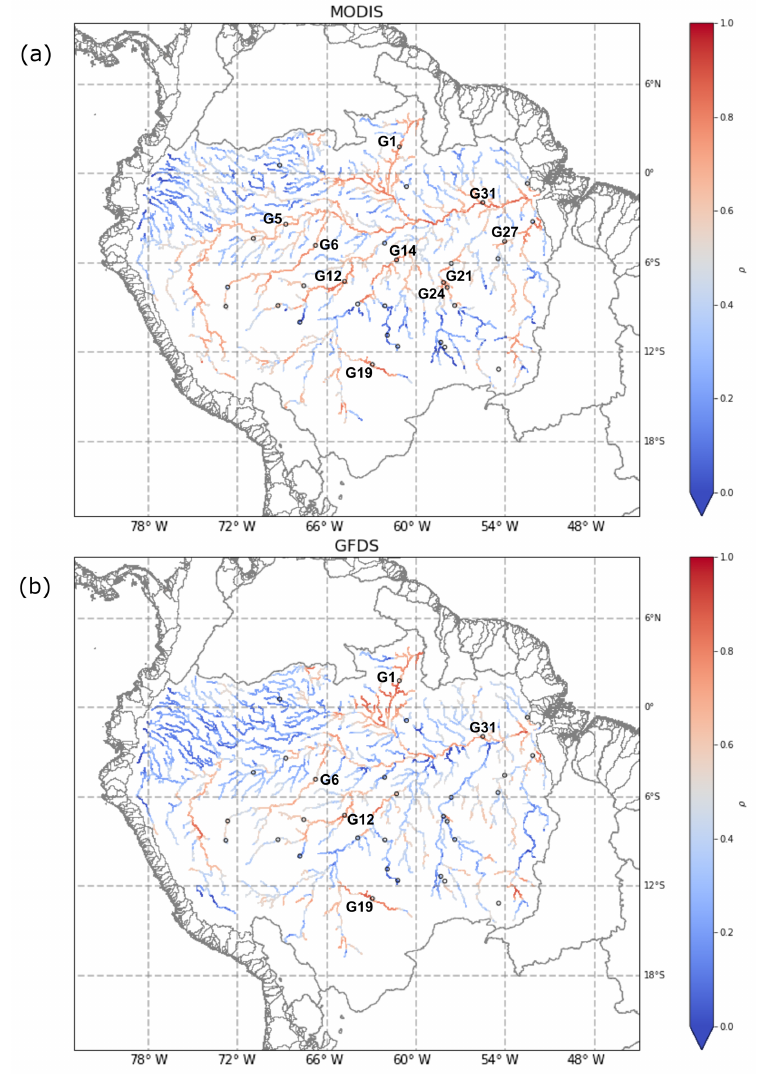
Figure 5. Spearman correlation ( ρ ) between modelled river channel storage and MODIS (a) and GFDS (b) water extent using the optimal grid cell selection method (method A) with a search window of 0 . 55 ◦ × 0 . 55 ◦ (circle: gauging station; circle with label: potential SGR sites where gauging data are